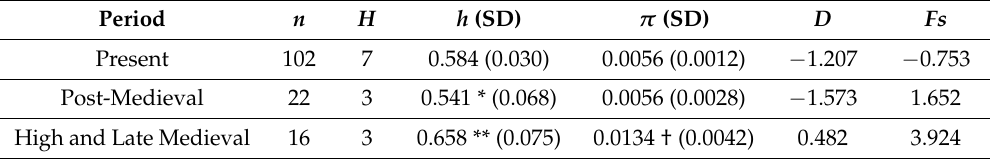
Table 1. Population summary statistics for the concatenated hypervariable part of the mitochondrial DNA (mtDNA) control region (204 bp) of the domestic goose comparing the Present Period, the Post-Medieval Period (16th–18th centuries) and the High and Late Medieval Periods (11th–15th centuries). Sample size ( n ), number of haplotypes ( H ), haplotype ( h ), and nucleotide diversity ( π ) with standard deviations (SD) and Tajima’s D and Fu’s Fs for testing population expansion. Statistically significant values of comparisons with the Present Period are indicated. Period n H h (SD) π (SD) D Fs Present 102 0.584 (0.030) − 0.753 Post-Medieval